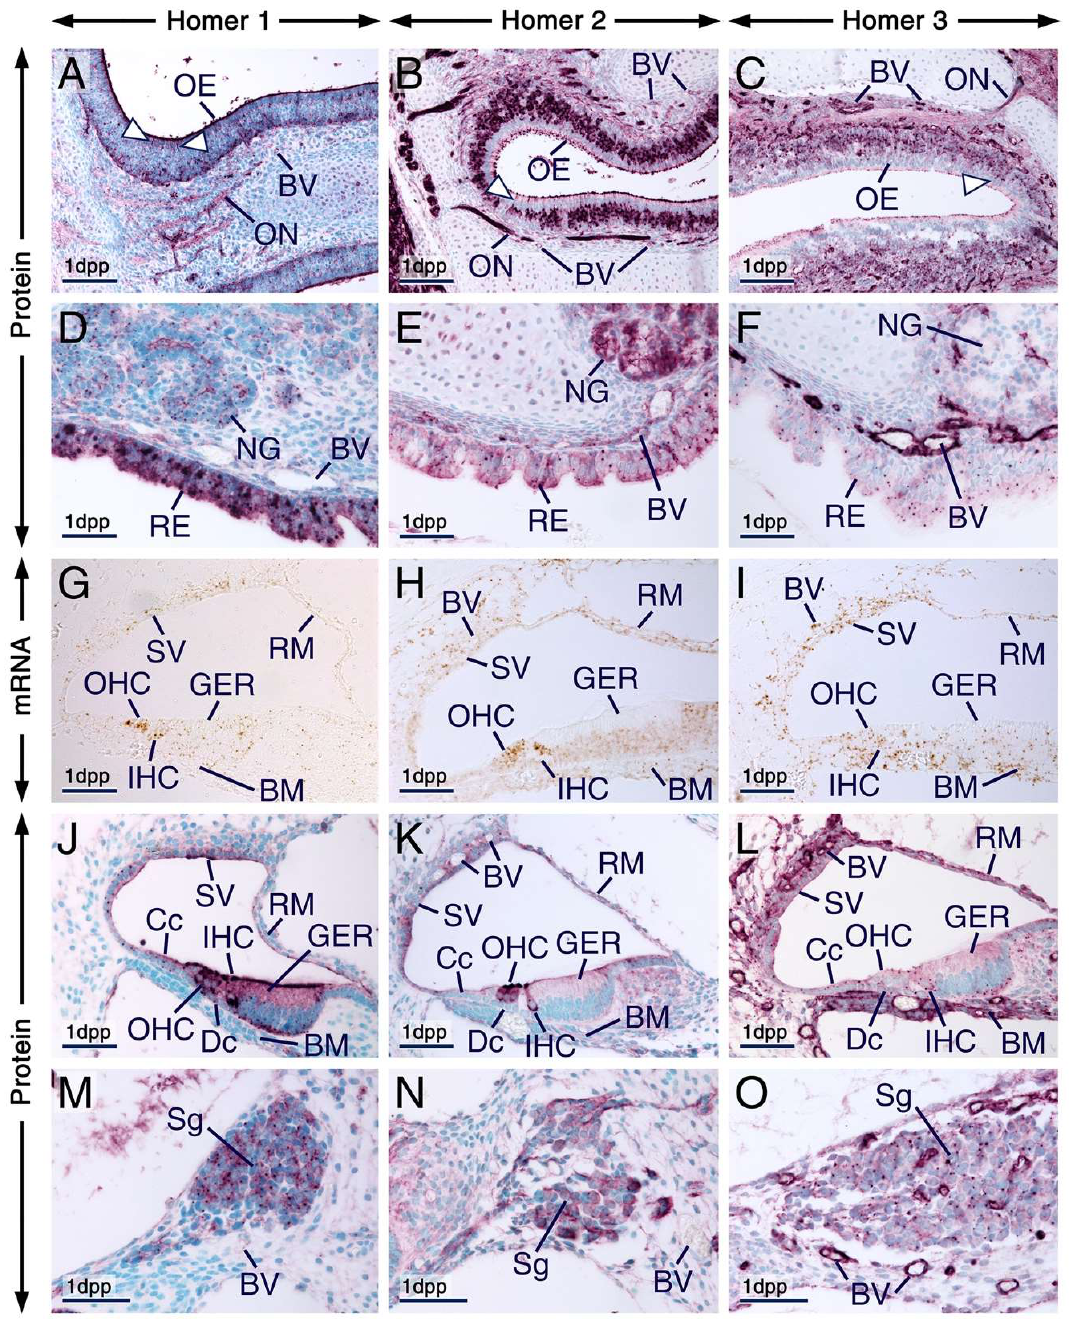
Figure 6. Expression patterns of Homer1, Homer2 and Homer3 in the olfactory and respiratory mucosae and in the cochlea. ( A – O ) Representative immunohistochemistry ( A – F , J – O ) and in situ hybridization ( G – I ) data in sections across the nasal cavity ( A – F ) and cochlea ( G – O ) at 1 day postpartum (1 dpp) showing the distribution patterns of Homer proteins (purple) and their encoding genes (brown). ( A – C ) Homer1 ( A ), Homer2 ( B ) and Homer3 ( C ) proteins are enriched in the apical surface (likely cilia of olfactory neurons and microvilli of supporting cells) of cells of the olfactory epithelium and are also detectable in intracellular puncta. Dendrites (arrowheads in A – C ) and axons, the latter forming the olfactory nerves, are Homer1-positive(+), Homer2+ and Homer3+, indicating